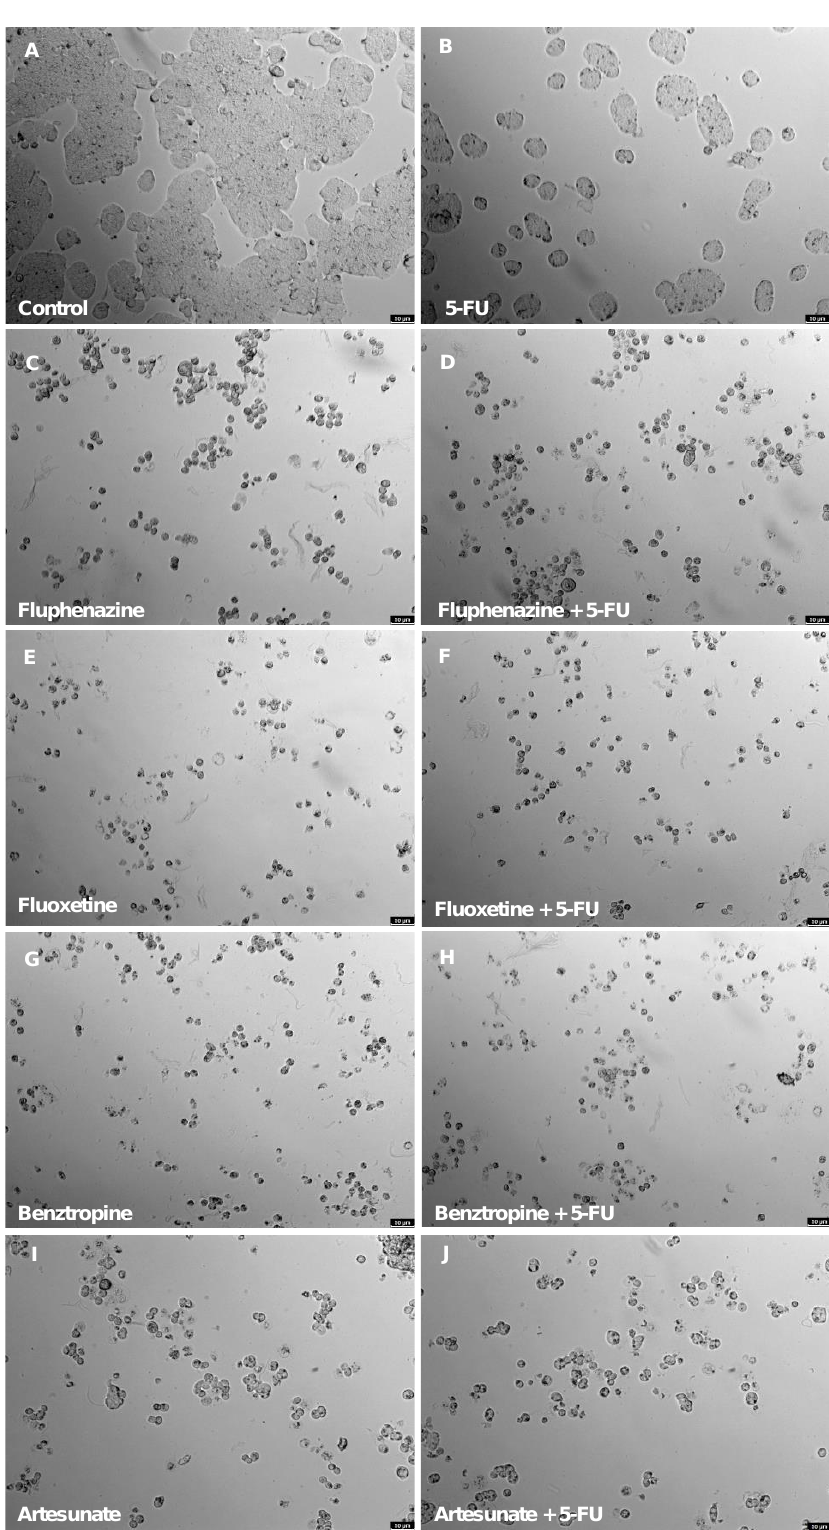
Figure 7. Microscopic cellular visualisation of HT-29 cells after 48 h of incubation with vehicle ( A ), 5-FU ( B ), fluphenazine ( C ), fluphenazine + 5-FU ( D ), fluoxetine ( E ), fluoxetine + 5-FU ( F ), benztropine ( G ), benztropine + 5-FU ( H ), artesunate ( I ) and artesunate + 5-FU ( J ) at concentrations of 4 × IC 50 of each drug.